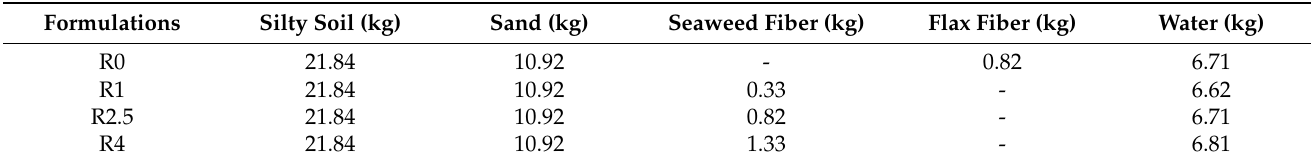
Table 7. Composition of the mixture.